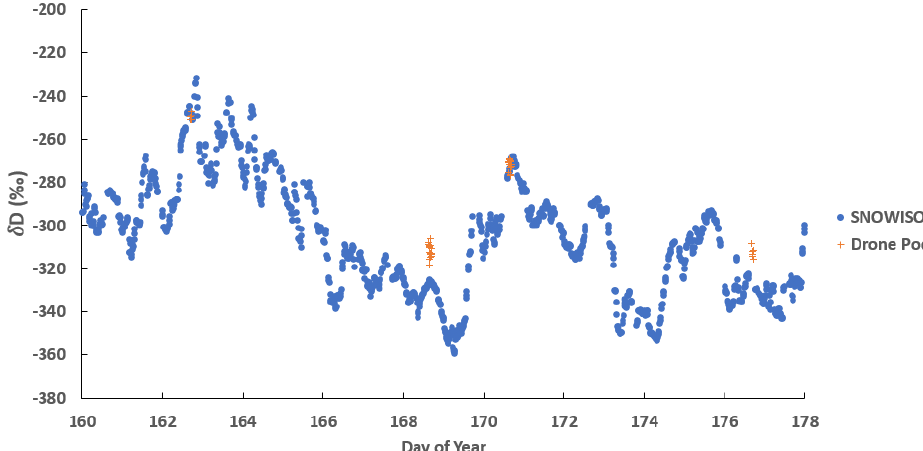
Figure A3. Comparison in δ D between the tower setup present at the EastGRIP camp in 2019 and 2m pod intercomparison measurements. Drone pod measurements on 163DOY (day of year) and 176DOY correspond to flask measurements taken at 2m during a flight mission. All measurements from both tower and UAV are tied to the same isotopic water standards listed in Table